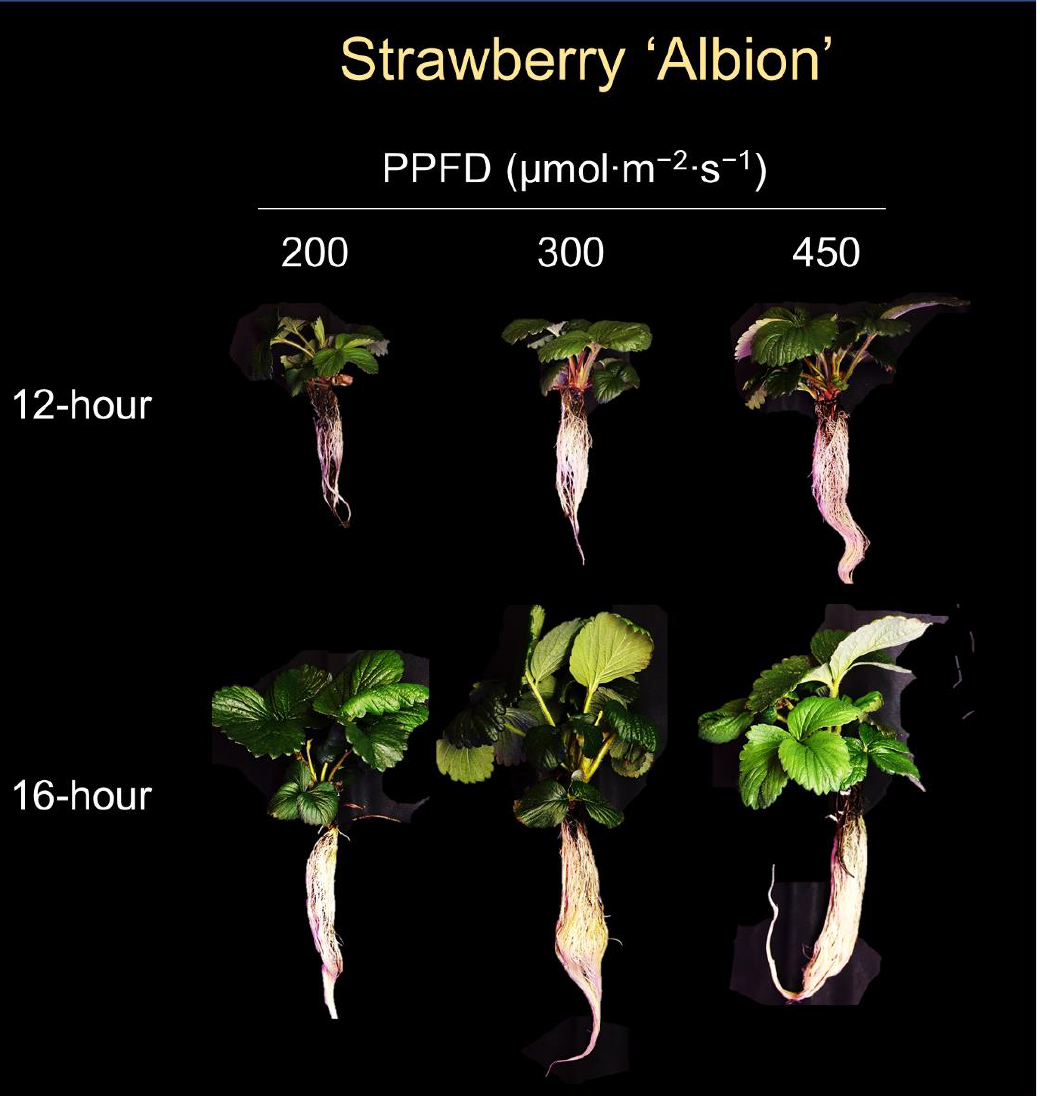
Figure 3. Strawberry ‘Albion’ plants grown for 5 weeks under six sole-source lighting treatments, which were comprised of combinations of two photoperiods (12-h and 16-h) and three photosynthetic photon flux densities (PPFDs) (200, 300, and 450 µ mol · m − 2 · s − 1 ). The photo was taken during the first replication.